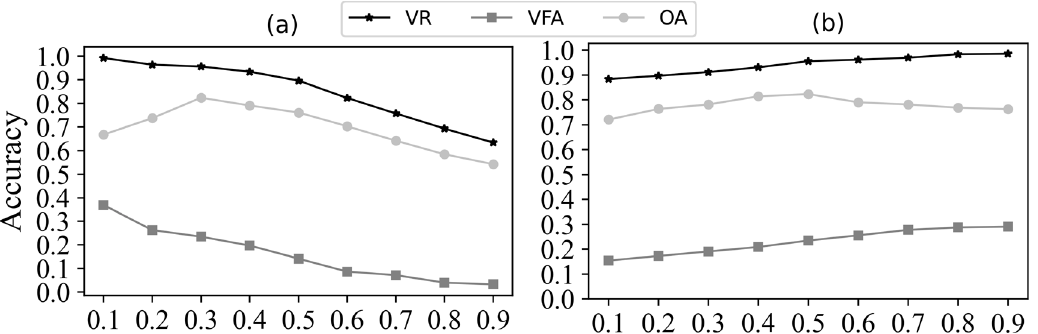
Figure 10. Different values of 𝜃 and 𝜇 for the singing voice results: ( a ) represents 𝜃 parameter influence and ( b ) represents 𝜇 parameter influence.